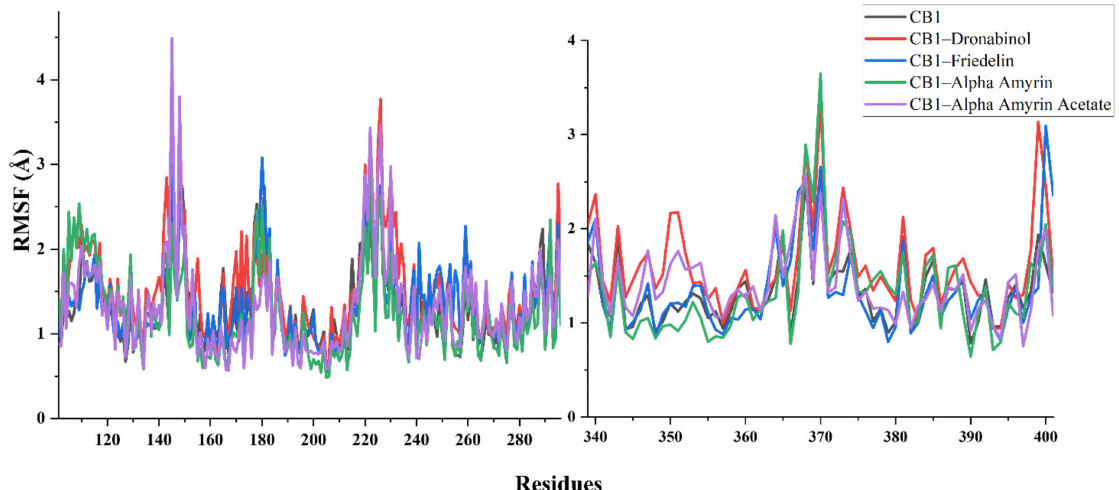
Figure 5. Structural behavioral changes of the CB1 protein by RMSF per residue with a focus on 101–300 and 333–401